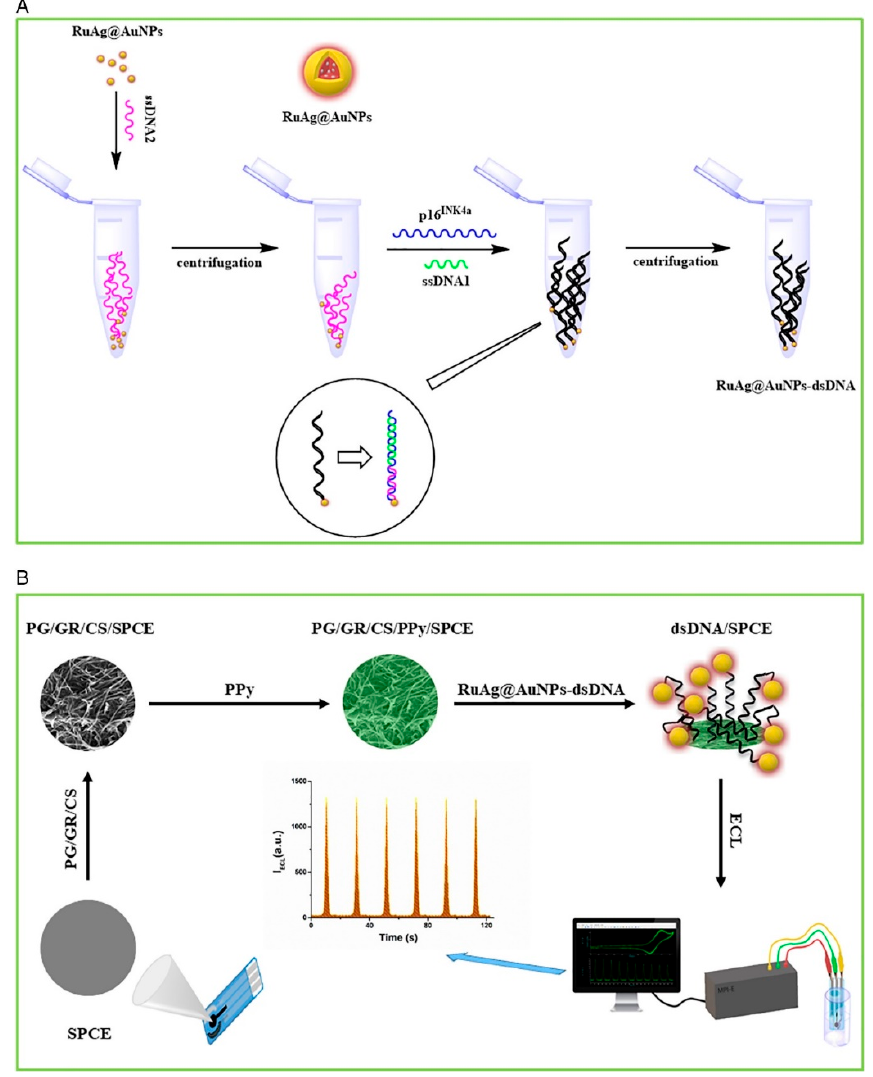
Figure 11. Schematic representation of the DNA-based ECL biosensor for detection of p16INK4a gene using functional paste-like nanofibers composites-modified carbon SPE, developed by Xu et al. [167]. Reproduced and adapted with permission of Elsevier. ( A ) RuAg@AuNPs-dsDNA preparation; ( B ) Paste-like nanofibers composites formation, electropolymerization on the modified carbon SPE surface and dsDNA immobilization.